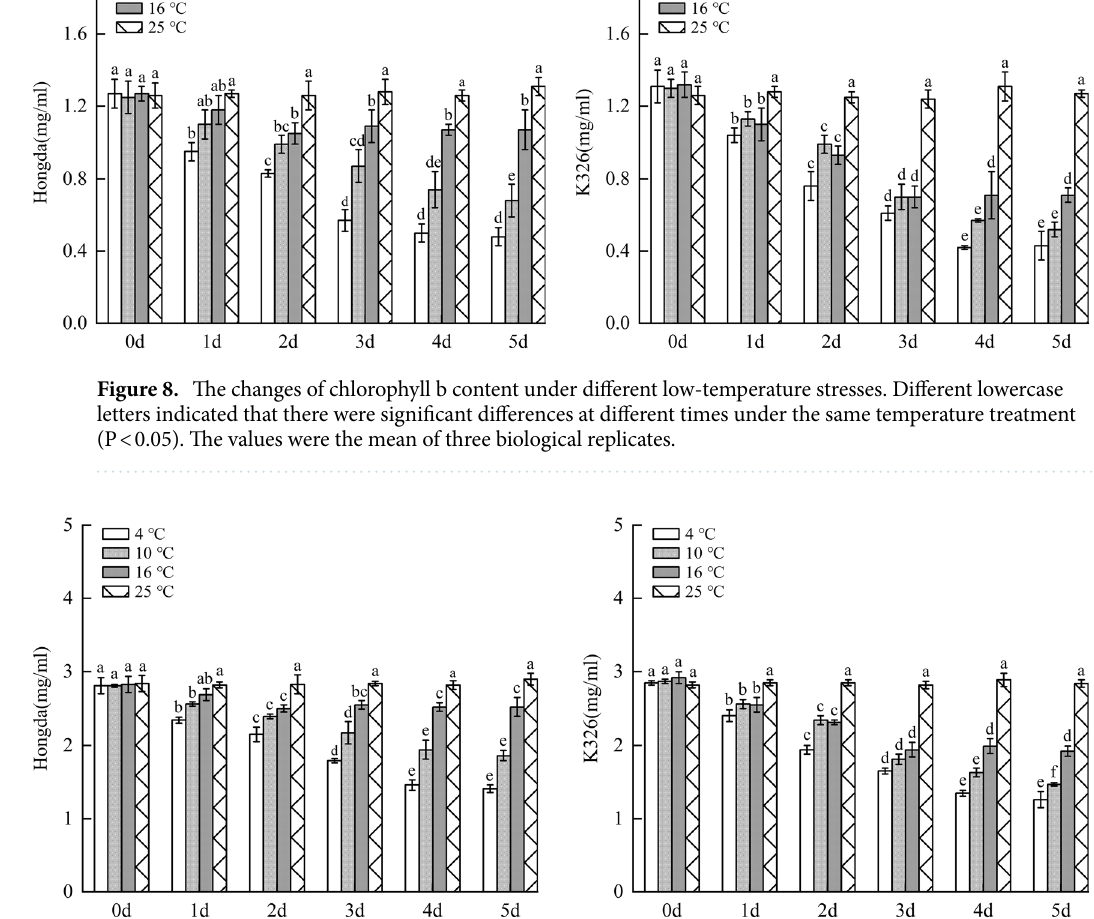
Figure 9. The changes of chlorophyll a + b content under different low-temperature stresses. Different lowercase letters indicated that there were significant differences at different times under the same temperature treatment (P < 0.05).The values were the mean of three biological